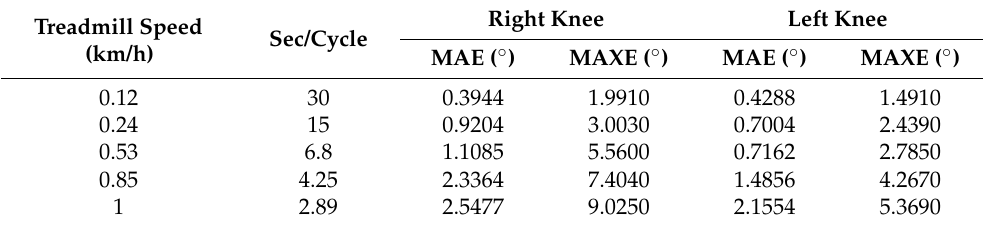
Table 4. Tracking error of the knee joint using ILC with PID